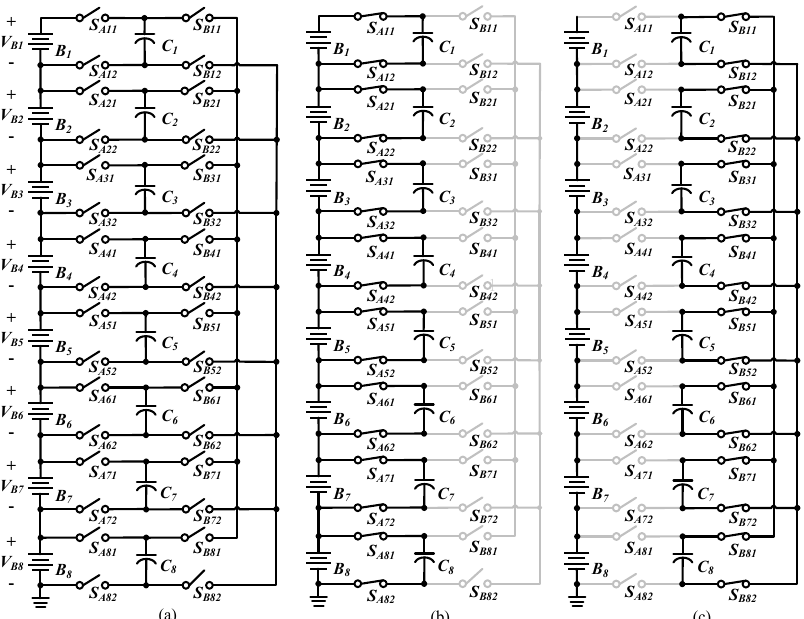
Figure 6. Series-parallel SC-based BE*: ( a ) circuit architecture; ( b ) first state; ( c ) second state. * Eight batteries are shown as examples. The single SC-based BE (Type G) is made up of a switch matrix and a capacitor.